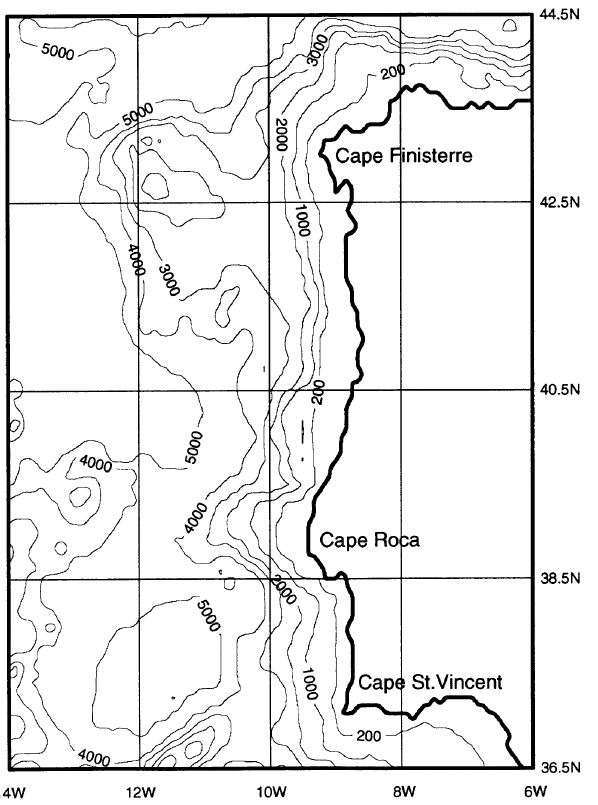
Fig. 1. Topography of the Iberian shelf-slope region. Depths in